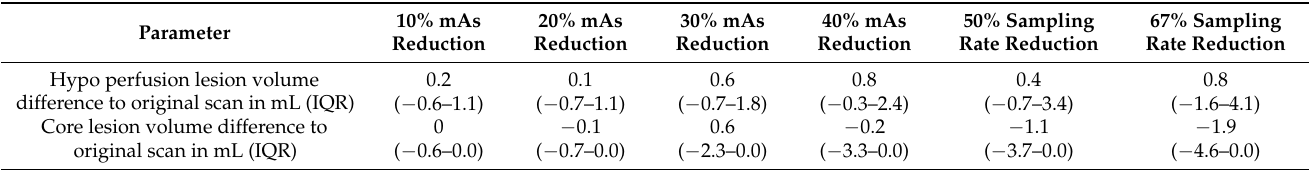
Table 3. Hypoperfusion and core volume differences as compared to the original acquisitions for all exposure and sampling rate reduction